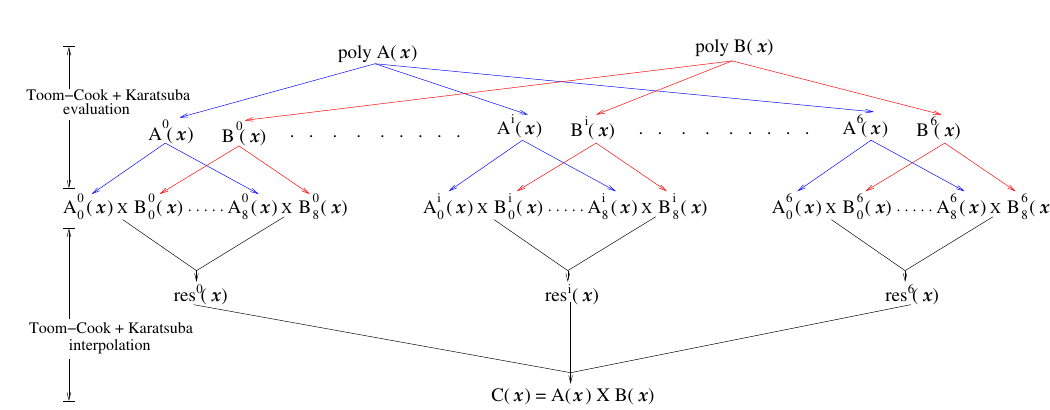
Figure 1: The Toom-Cook-4-way and Karatsuba multiplication used in Saber. Wrapping up, to multiply two polynomials A ( x ) and B ( x ) with degree n = 256 we have to perform 7 × 9 = 63 polynomial multiplications of degree 16 using a combination of Toom-Cook-4, Karatsuba, and schoolbook multiplication. The pseudo-code for combined Toom-Cook-4, Karatsuba, and schoolbook multiplication used in Saber is shown in Alg. 4.